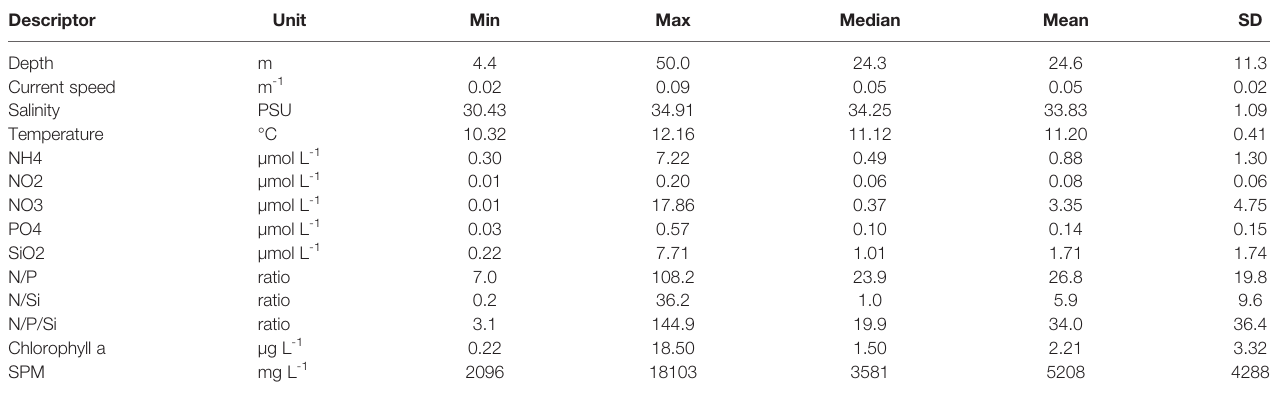
TABLE 3 | Descriptive statistics of abiotic